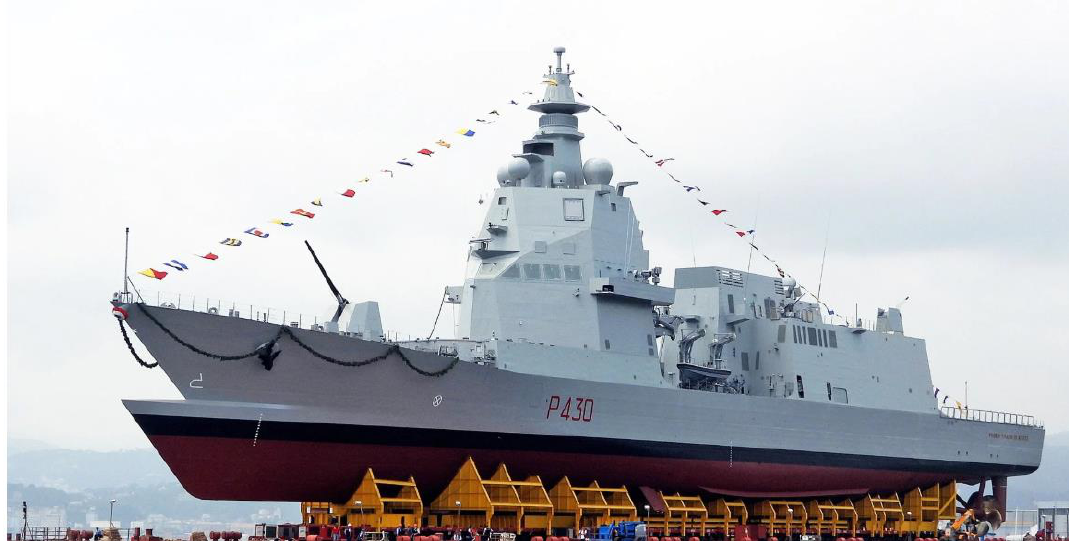
Figure 27. Paolo Thaon di revel ship with a polyhedral bow. https://www.armadainternational. com/2019/07/italian-navy-launches-paolo-thaon-di-revel/ (accessed on 1 September